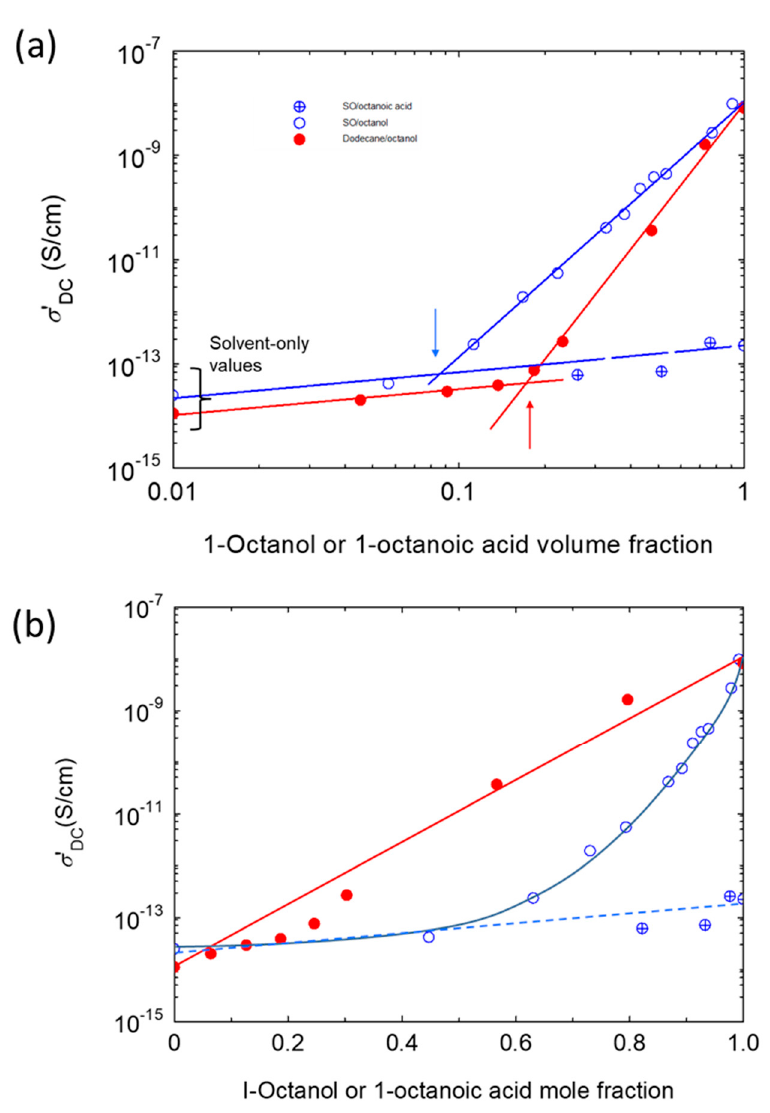
Figure 7. Direct current (DC) electrical conductivity of SO mixtures with octanol and octanoic acid as a function of concentration. ( a ) Log–log plot of σ ′ DC against volume fraction. The arrows indicate the points of intersection of the lines drawn through data in high and low concentration regions. Data for dodecane/octanol (in red) have been included for comparison. ( b ) The same σ ′ DC data as in ( a ) plotted logarithmically against the mole fraction of the polar component. All lines have been drawn to guide the eye.